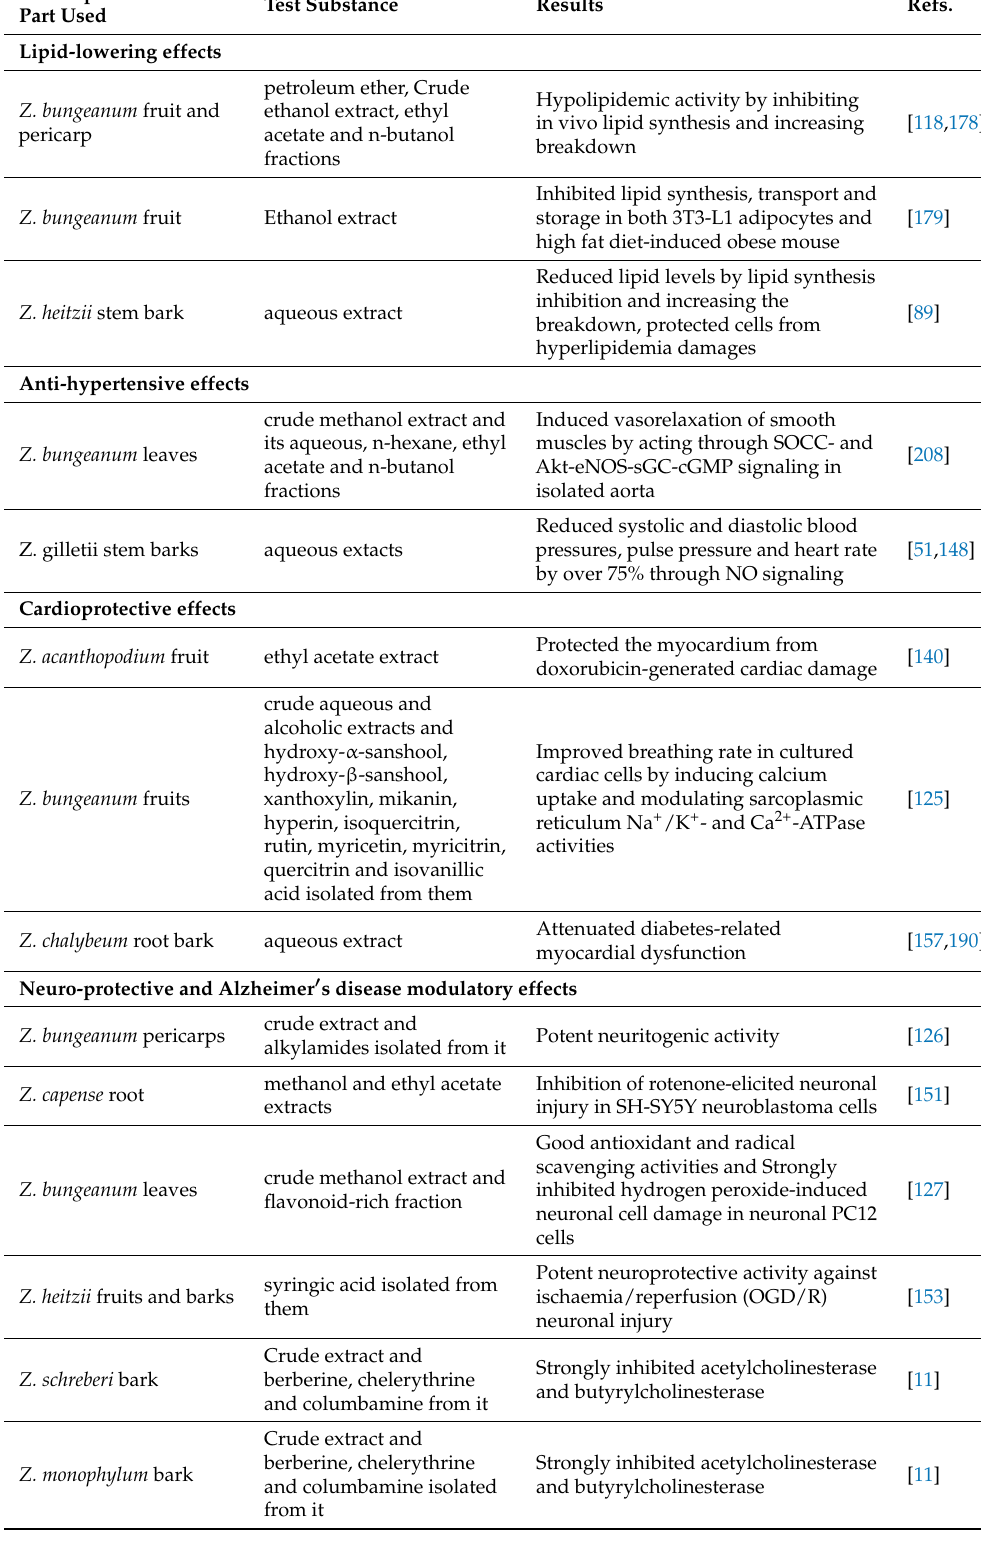
Table 10. Cont. Plant Species and Part